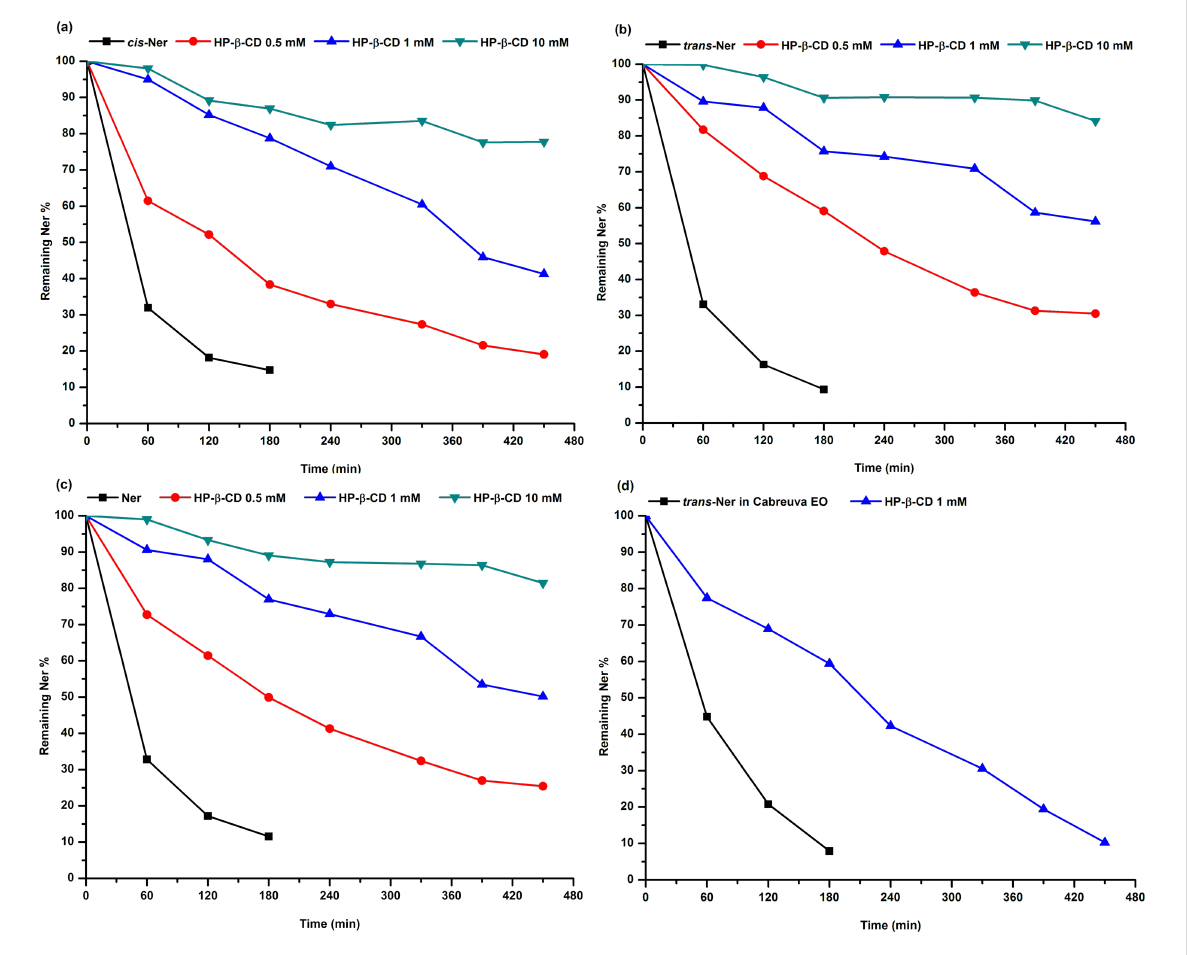
Figure 5: Photodegradation kinetics of cis -Ner (a), trans -Ner (b), the isomer mixture Ner (c) in the absence and presence of increasing concentra- tions of HP- β -CD (0.5, 1 and 10 mM) and of trans -Ner in cabreuva EO (d) in the absence and presence of 1 mM HP- β -CD under UV light